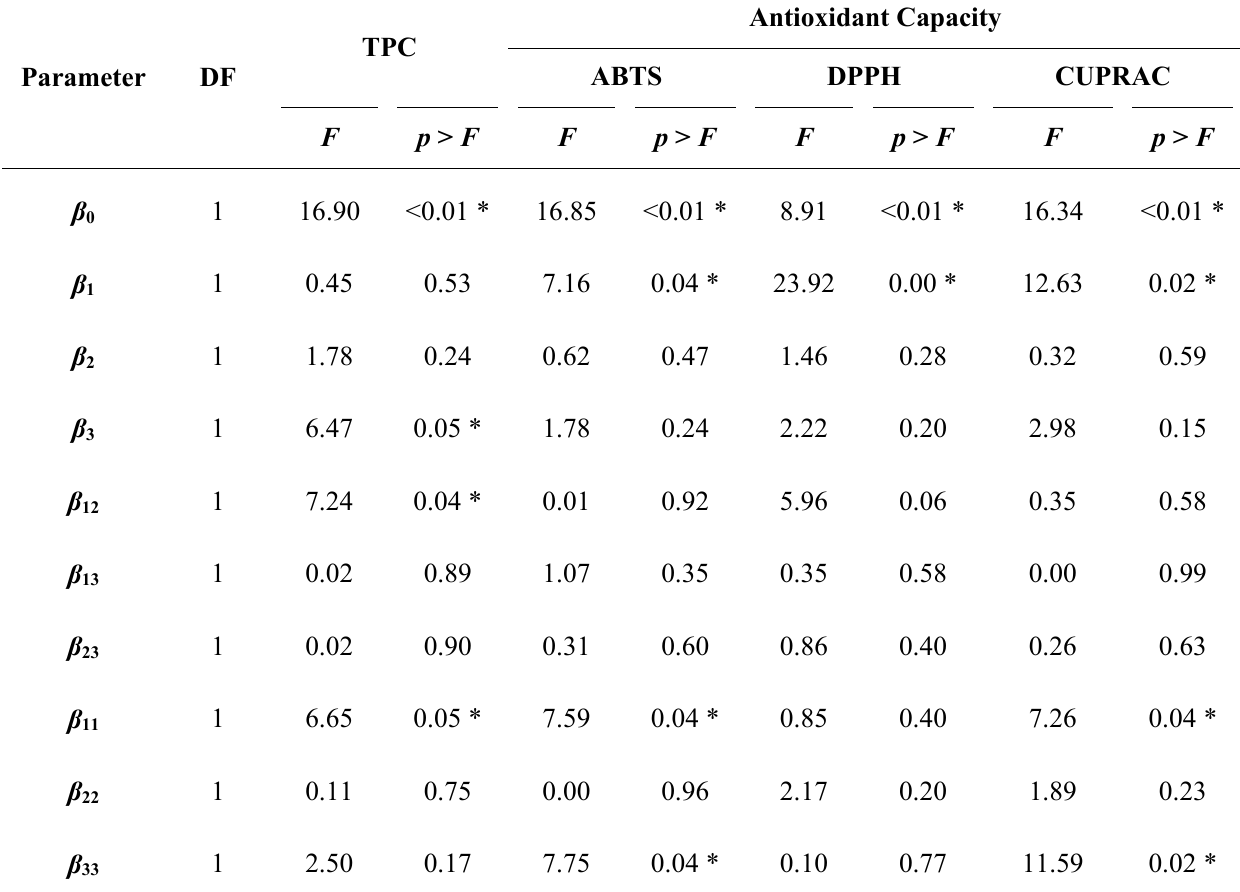
Table 3. Analysis of variance for the experimental